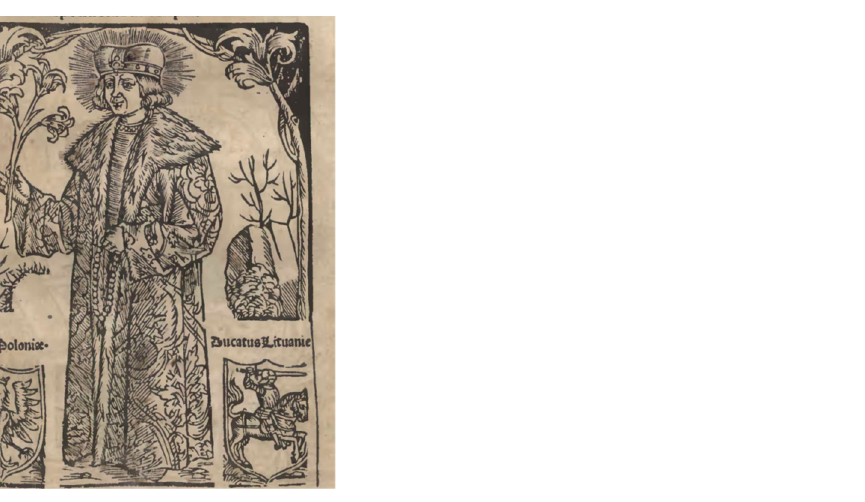
Figure 2. Portrait of Kazimierz Jagiello ń czyk. In (Ferreri 1521a). Image in the public domain.